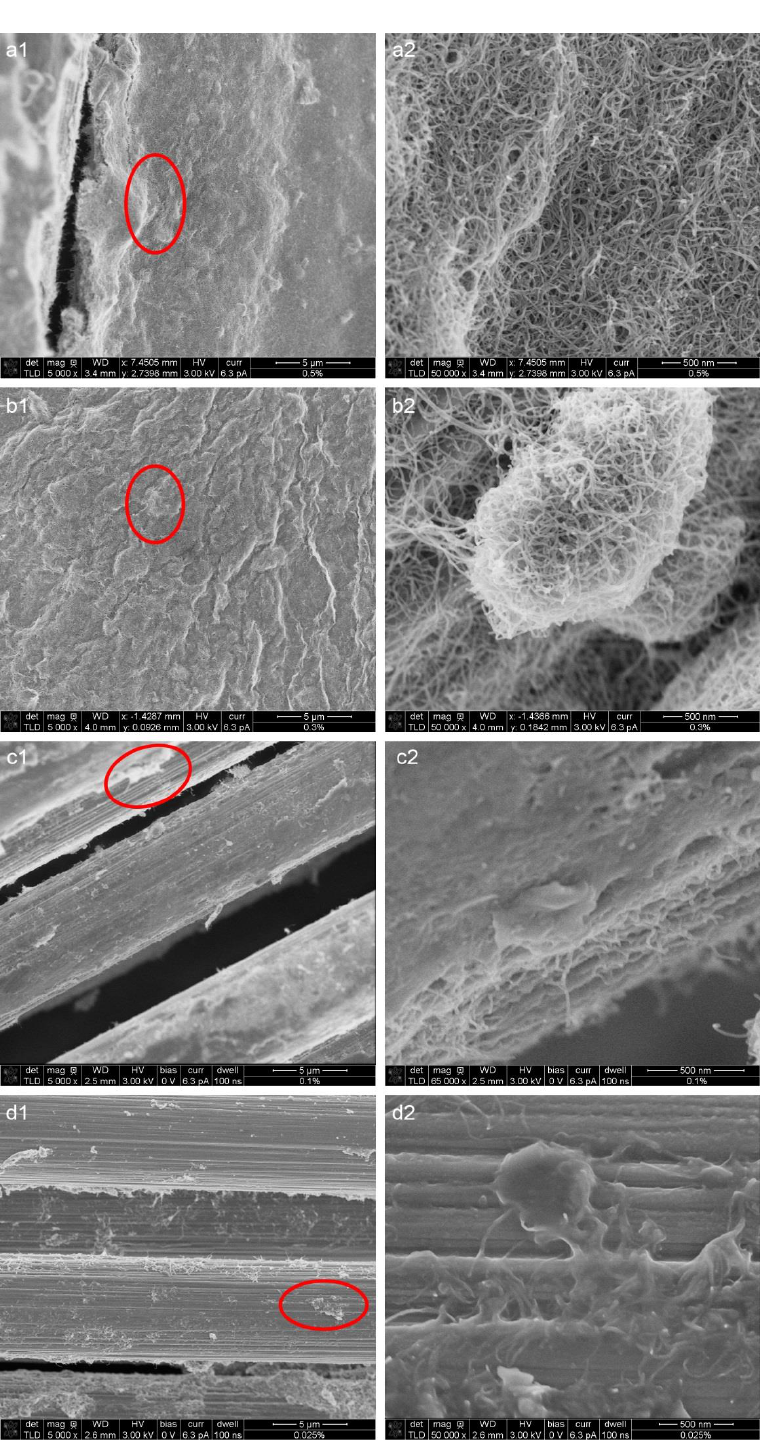
Figure 1. SEM images of deposited carbon nanotube (CNT) on carbon fiber (CF) fabrics using ( a ) 0.5 wt% Nanocyl suspension, ( b ) 0.3 wt% Nanocyl suspension, ( c ) 0.1 wt% Nanocyl suspension, and ( d ) 0.025 wt% Nanocyl suspension, at an electric field 10 V/cm and deposition time of three min for each spot on the fabric. ( a2 – d2 ) are zoomed-in images with respect to the red-ring marked region in image of ( a1 – d1 ),